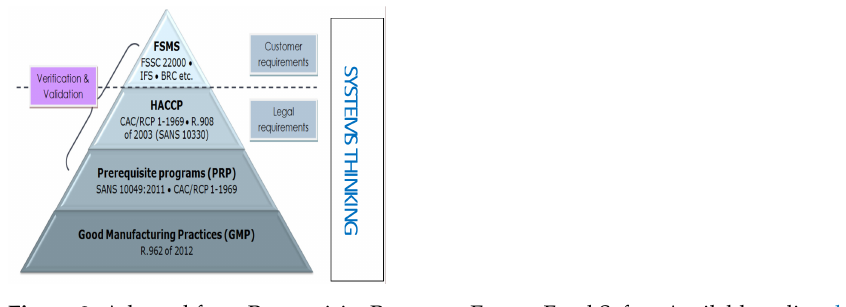
Figure 2. Adapted from Prerequisite Programs Ensure Food Safety Available online: https://images. app.goo.gl/jFnRtoUP3ByyLyn77 (accessed on 20 June 2021).